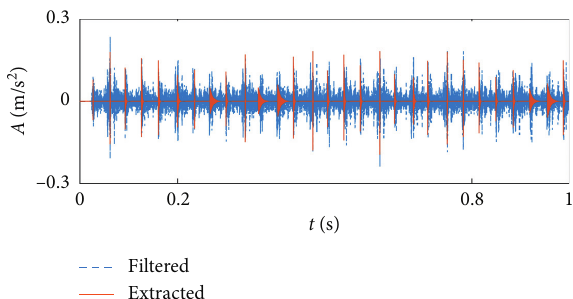
Figure 16: Experimental normal signal processed by the proposed method.